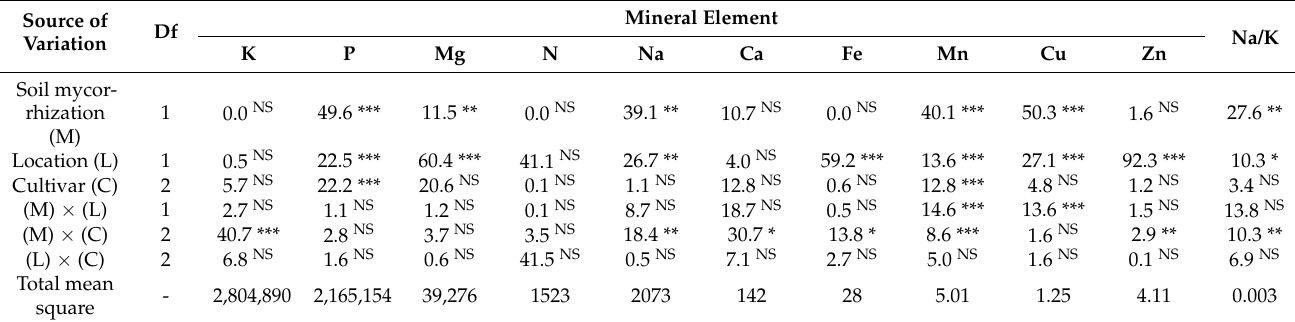
Table 4. Mean square as percentage of total of effects resulting from analysis of variance.